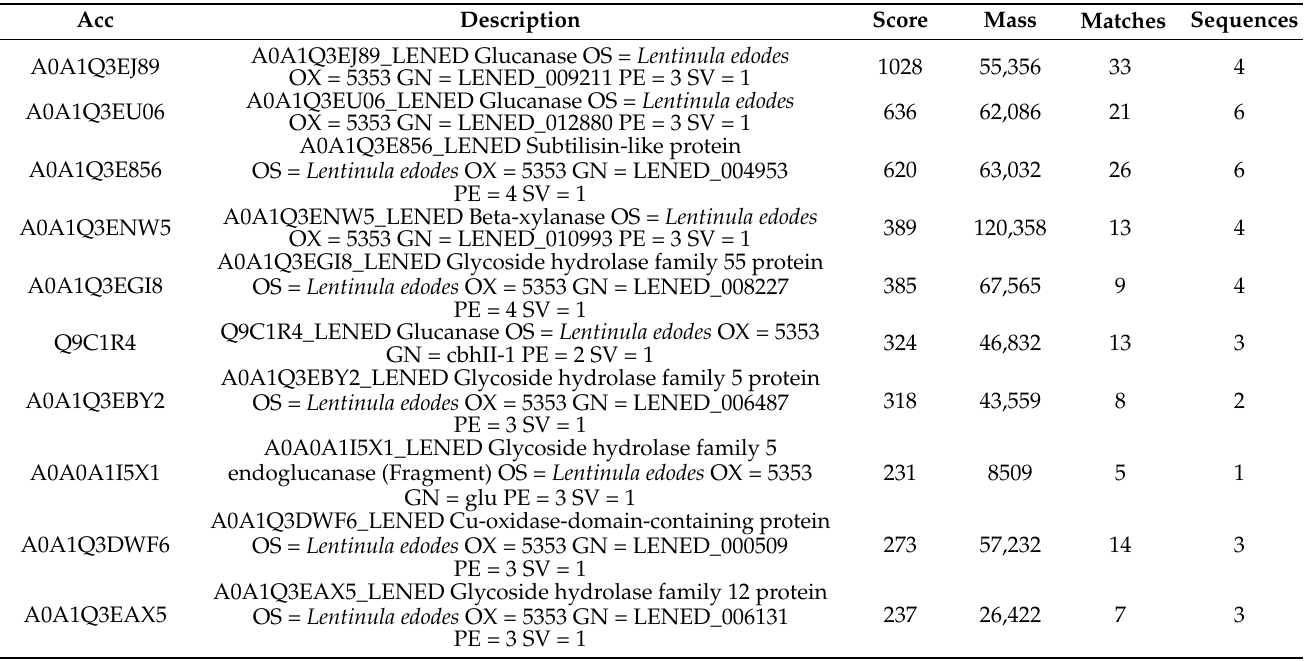
Table 1. Detected proteins of the fungal enzyme preparation. MASCOT search results are shown as representatives for the factor 1000 sample at 0 h after the addition of the enzyme preparation against the UniProt_Lentinula_Edodes